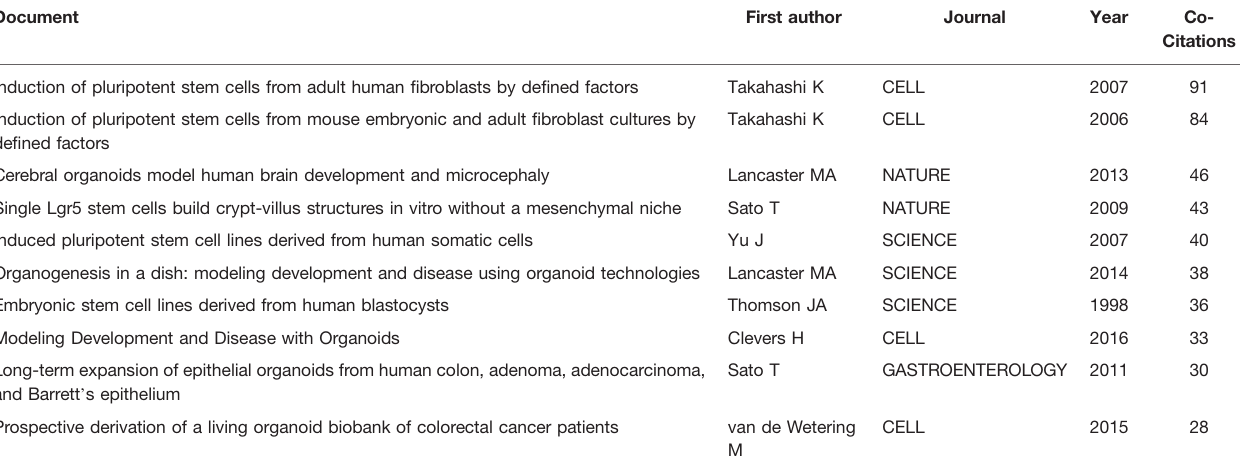
TABLE 6 | The 10 most co-cited references of stem cell precision medicine in the past 5